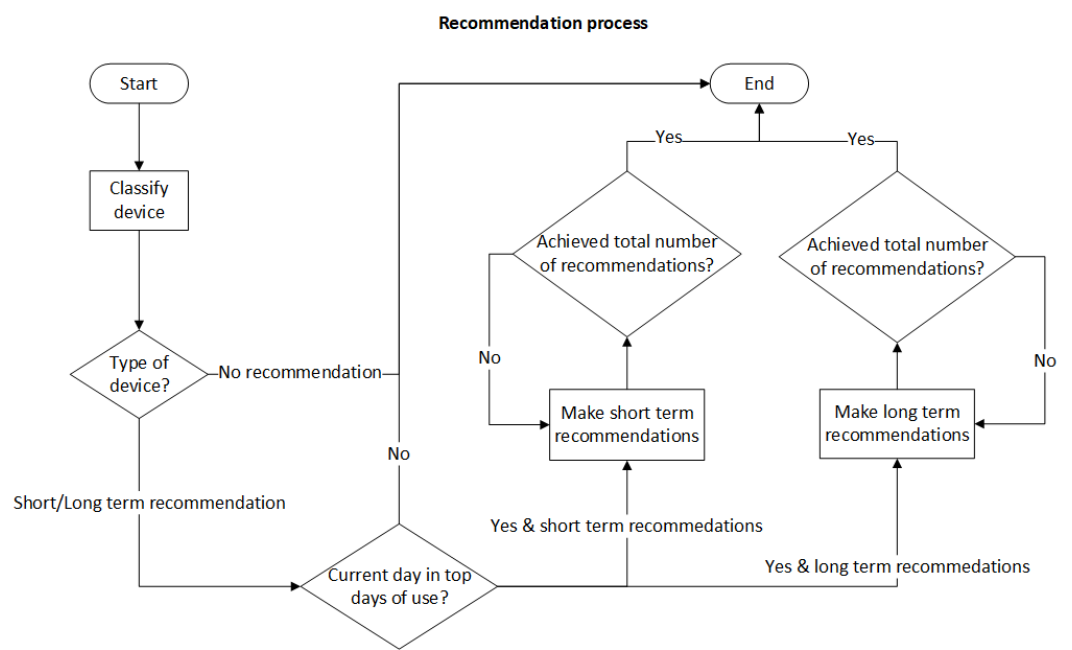
Figure 2. Recommendation process followed for every electric